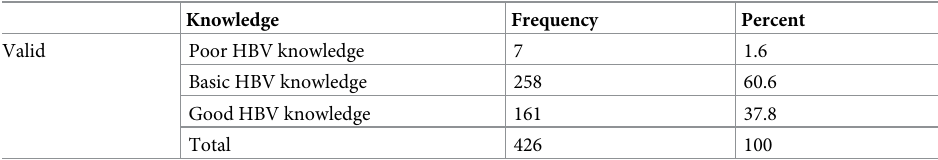
Table 2. Hepatitis B knowledge